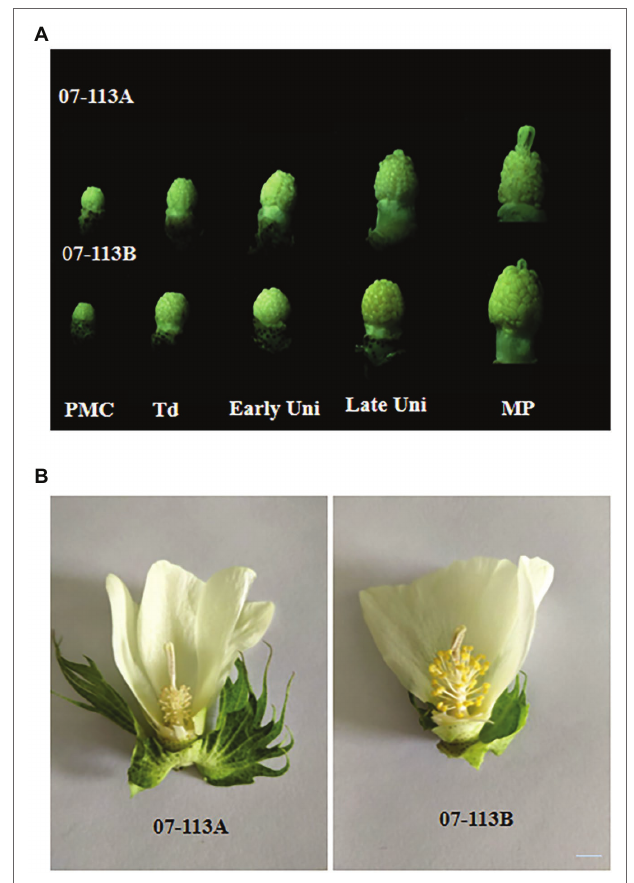
FIGURE 1 | Comparison of the morphological characteristics among 07-113A and 07-113B. (A) Morphological characteristics of anther development of 07-113A and 07-113B in cotton. (B) The flower morphological characteristics of 07-113A and 07-113B in cotton. PMC, pollen mother cell; Td, Ttrad; Early Uni, early uninucleate; Late Uin, late uninucleate; and MP, mature pollen. Bar = 0.5